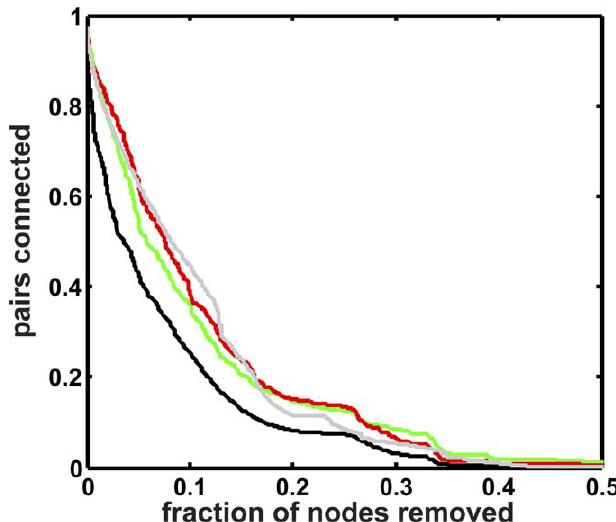
Figure 9. Modularity Analysis for the Yeast Protein–Protein Interaction Network with Topological Clustering Fraction of pairs of genes that remain connected upon removal of nodes with the highest betweenness centrality, for the highly curated yeast protein–protein interaction network and synthetic lethal and dosage rescue pairs of Reguly et al. [18]. Red line, synthetic lethal pairs; green, dosage rescue pairs; black solid line, random pairs; grey line, random pairs of the randomized network.